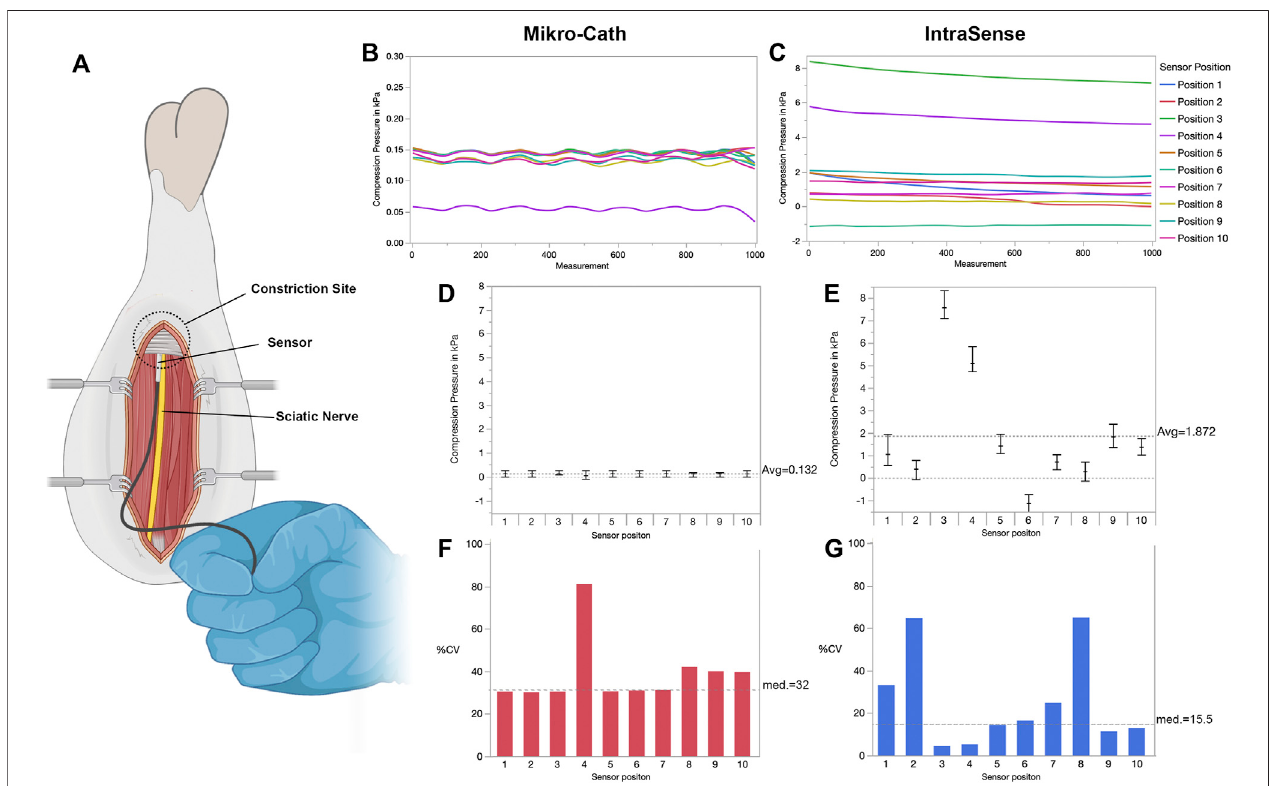
FIGURE4| Perineuralpressuremeasurementinan exvivo chickenlegmodel (A) Experimentalset-upwiththesurgicallyexposedsciaticnerveinthechickenthigh. Thesensorisadvancedalongthenerveandpositionedbetweenthenerveandadjacent fi bromusculartissue (B,C) Within theconstriction site,serialnerve compression pressure measurements were performed in ten positions for each sensor. The examiner was instructed to recreate the same sensor position each time. Similar to the synthetic nerve compressionmodel, the recorded pressure differed signi fi cantly between positions (D) The averagecompression pressure and standard deviation per sensor position measured with the Mikro-Cath and (E) IntraSense respectively. Of note, accidental displacement or rotation of the senor may lead to negative pressure readings as shown in position 6 with the IntraSense device (F) Both sensors, the Mikro-Cath and (G) IntraSense show considerable measurement variability expressed as precent coef fi cient of variation (%CV) for each individual sensor position. Figures were designed with